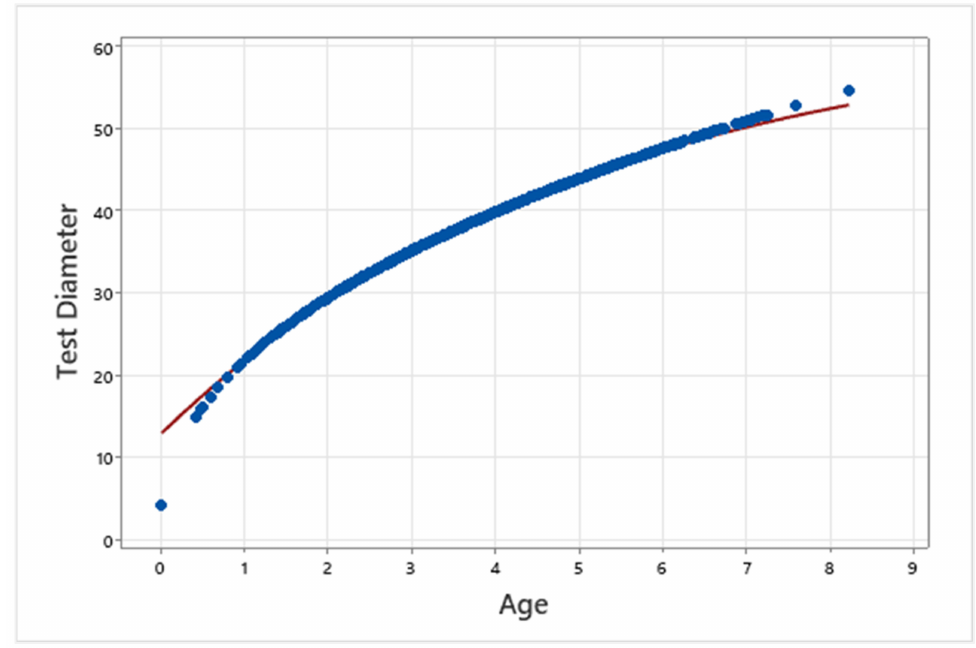
Figure 6. Von Bertalanffy growth equation for the entire Arbacia lixula population sampled.